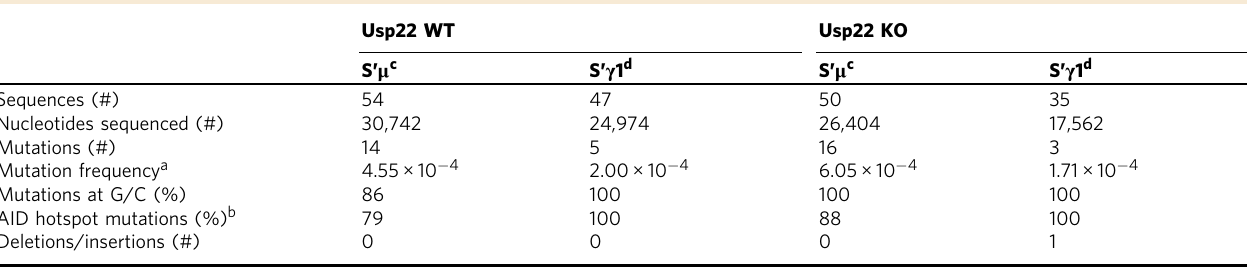
Table 1 Frequency of mutations upstream of switch μ or γ 1